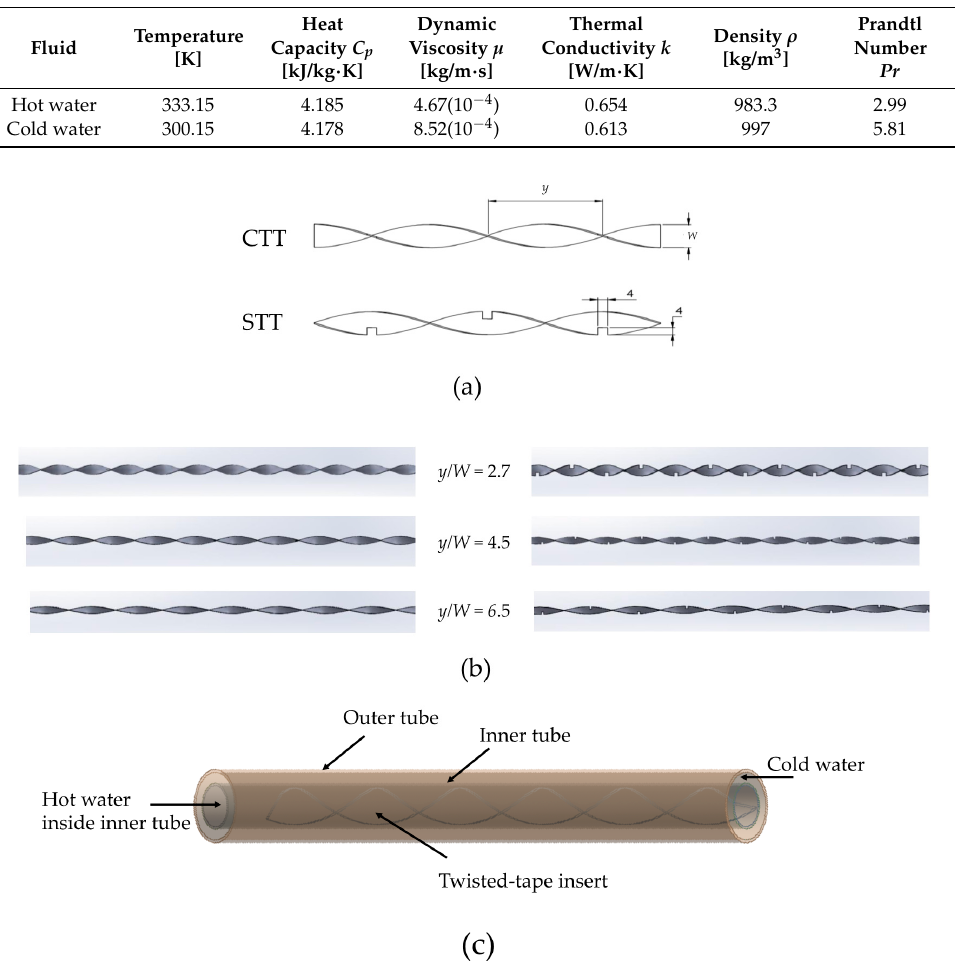
Table 1. Thermo-physical properties of the hot and cold water at inner and outer tube inlets [15].